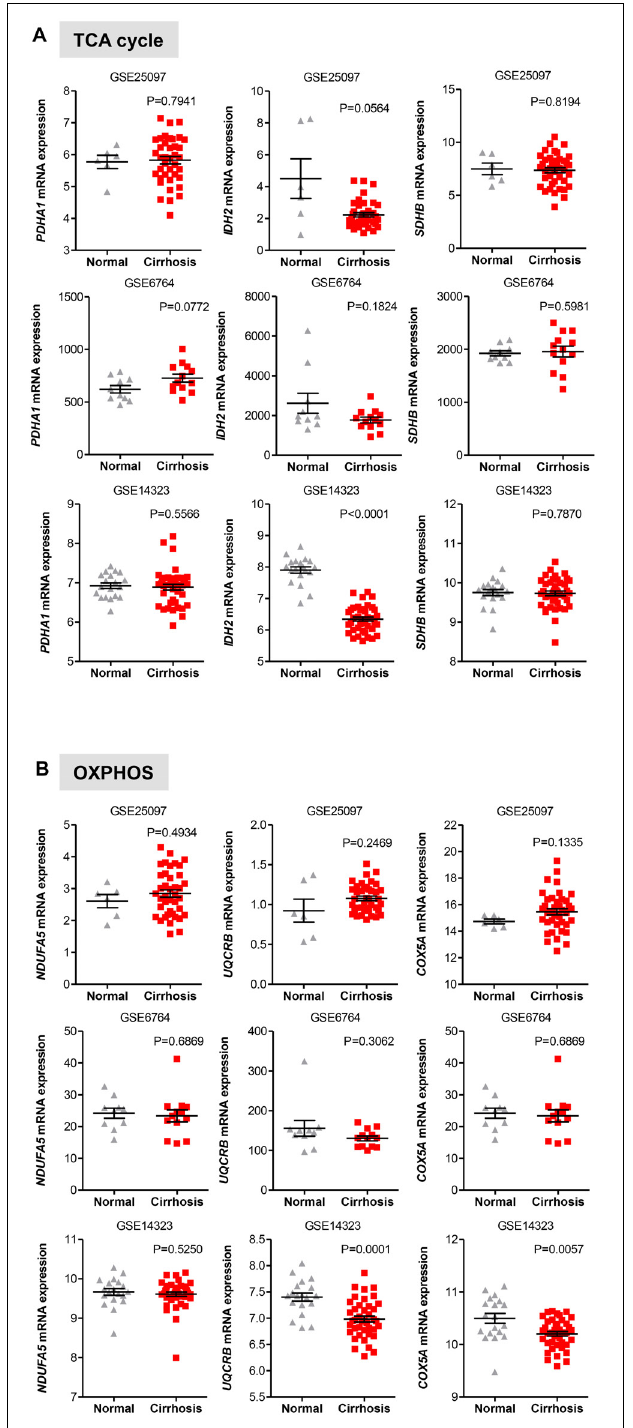
FIGURE 6 | Gene expression of TCA and OXPHOS enzymes in cirrhotic livers. (A,B) Scatterplots showing homogenous expression of representative TCA and OXPHOS biomarkers in cirrhotic livers compared to normal healthy liver tissues in three independent clinical data sets GSE25097, GSE6764, and GSE14323 (Wurmbach et al., 2007; Sung et al., 2012; Levy et al., 2016). The horizontal lines indicate mean ± SEM P -values were calculated by non-parametric Mann–Whitney